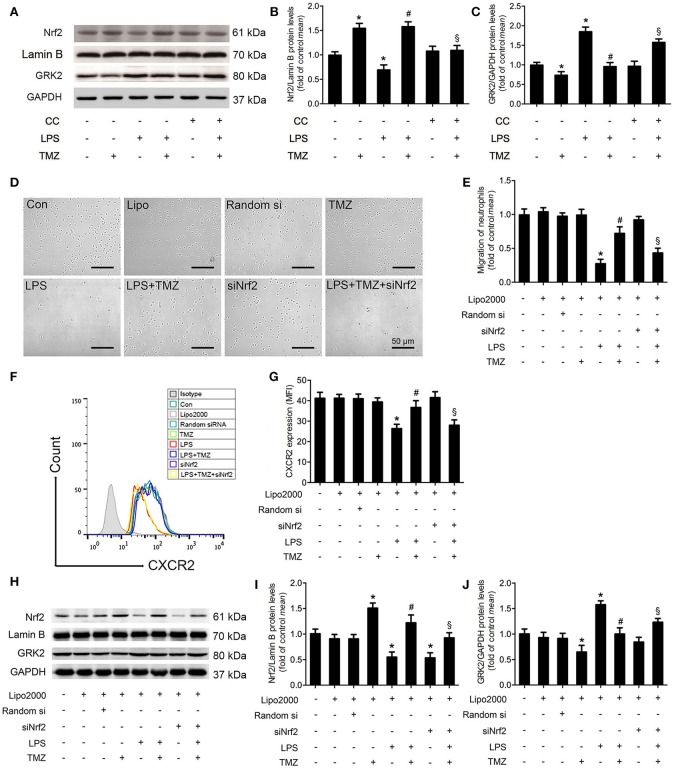
TMZ promoted neutrophil migration by decreasing GRK2 and increasing CXCR2 expression in an AMPK/Nrf2 dependent manner. (A) BMDNs were first treated with CC (1 μM) for 1 h, then subjected to LPS stimulation (5 μg/ml) for 1 h, subsequently treated with TMZ (20 μM) for 2 h. Western blotting analysis of nuclear Nrf2 and total GRK2 in response to different stimulations. Lamin B and GAPDH were used as loading controls, respectively. (B,C) Quantification of Nrf2/Lamin B and GRK2/GAPDH was performed from the western blotting and expressed as fold induction. (D) BMDNs were first transfected with si-Nrf2 for 24 h, then subjected to LPS stimulation (5 μg/ml) for 1 h, subsequently treated with TMZ (20 μM) for 2 h. Representative images of transwell assays for BMDNs under optical microscope. Scale bar: 50 μm. (E) Relative quantitative assay of migrating BMDNs under optical microscopy. (F) Flow cytometry was performed to examine the expression of CXCR2 on the membrane of BMDNs. (G) Quantitative assay of CXCR2 expression by FACS. (H) Western blotting analysis of nuclear Nrf2 and total GRK2 in response to different stimulations after transfection. Lamin B and GAPDH were used as loading controls, respectively. (I,J) Quantification of Nrf2/Lamin B and GRK2/GAPDH was performed from the western blotting and expressed as fold induction. Data is presented as mean ± SEM in vivo and mean ± SD in vitro of three independent experiments. *P < 0.05 vs. Con group; #P < 0.05 vs. LPS group; §P < 0.05 vs. LPS+TMZ group.